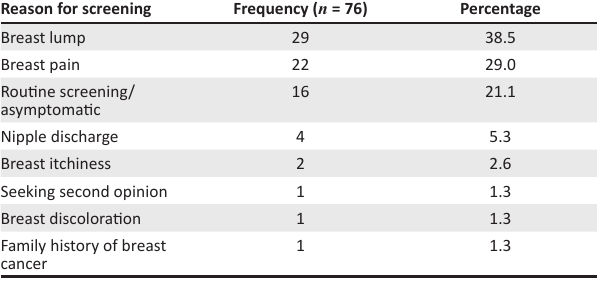
TABLE 2: Reason for attending breast cancer screening clinics.